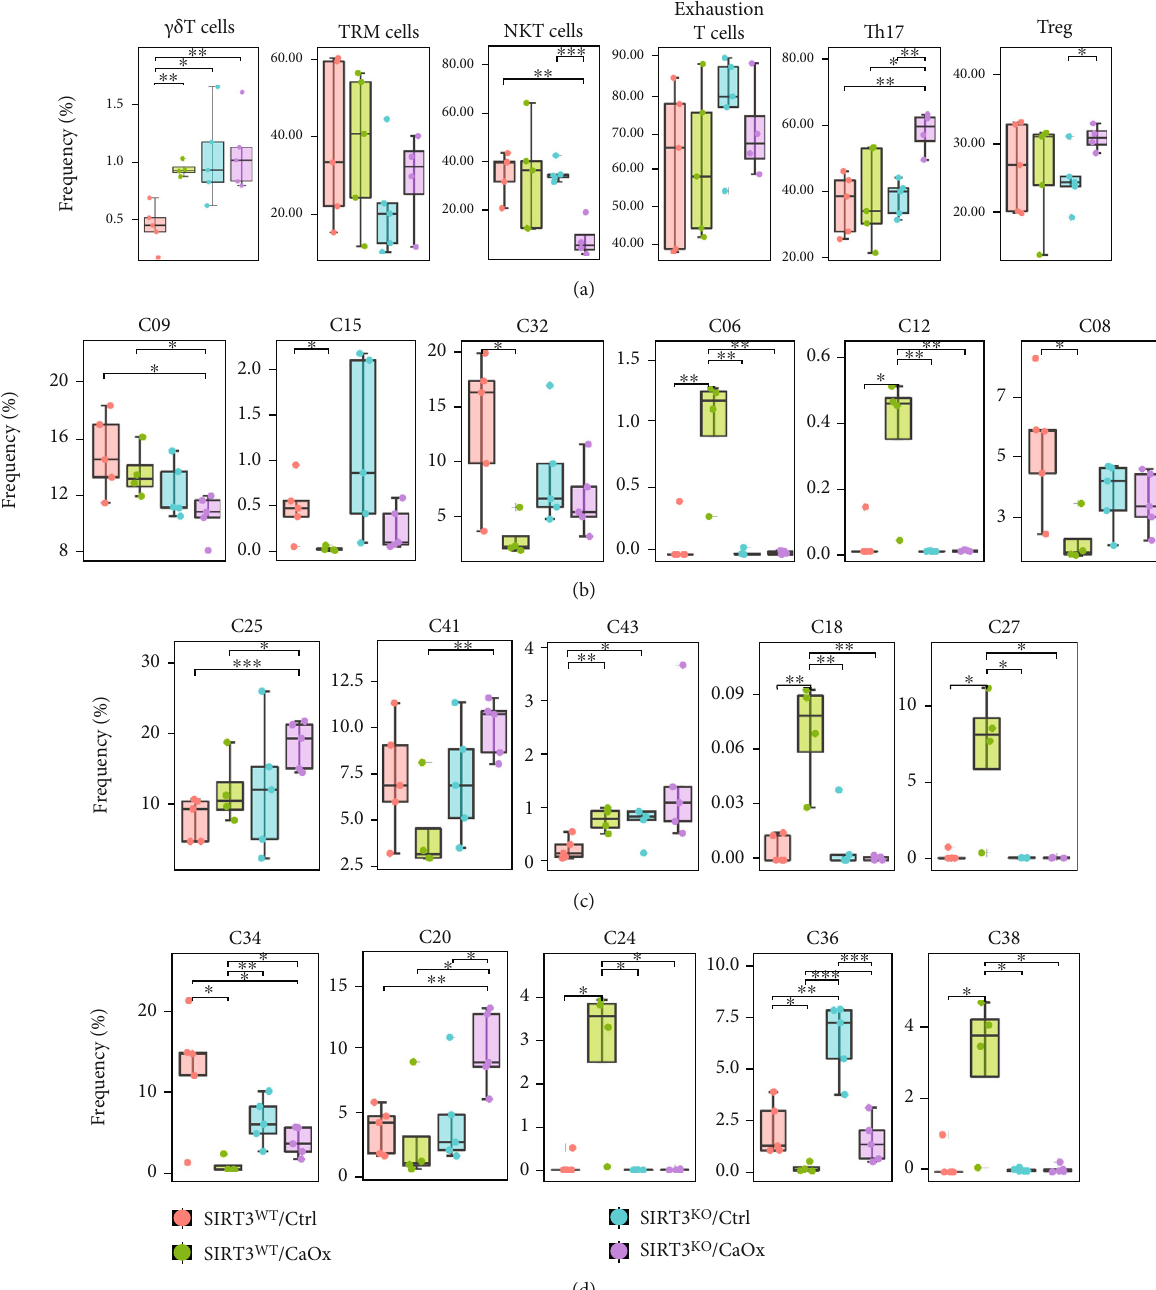
Figure 6: Subphenotypes of (a, b) T cells, (c) macrophages, and (d) other immune cell populations dominantly a ff ected by SIRT3 knockout and CaOx inducement. ∗ P < 0 : 05 , ∗∗ P < 0 : 01 , ∗∗∗ P < 0 : 001